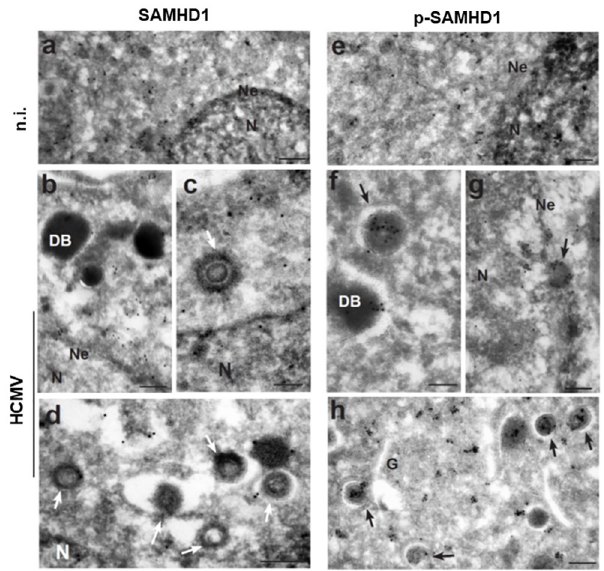
Fig 9. pT592-SAMHD1 associates with viral particles and dense bodies. HFFs, not infected (n.i.) or infected with AD169, were processed at 3 dpi for Cryo-IEM analysis and immunolabeled using primary specific antibodies against SAMHD1 (a-d) or pT592-SAMHD1 (e-h). One representative experiment out of seven different immune gold-labeling experiments is shown. Sparse labeling of SAMHD1 and pT592-SAMHD1 was detected in uninfected cells in the nucleus and in the cytoplasm (a, e). In infected cells, viral structures were not labeled with SAMHD1 gold (b-d; white arrows) but were gold-decorated with pT592-SAMHD1 (f-h; black arrows). N, nucleus; Ne, nuclear envelope; G, Golgi apparatus, DB, dense bodies. Bars a, b, d, e, g, h = 200nm; c, f = 100 nm.